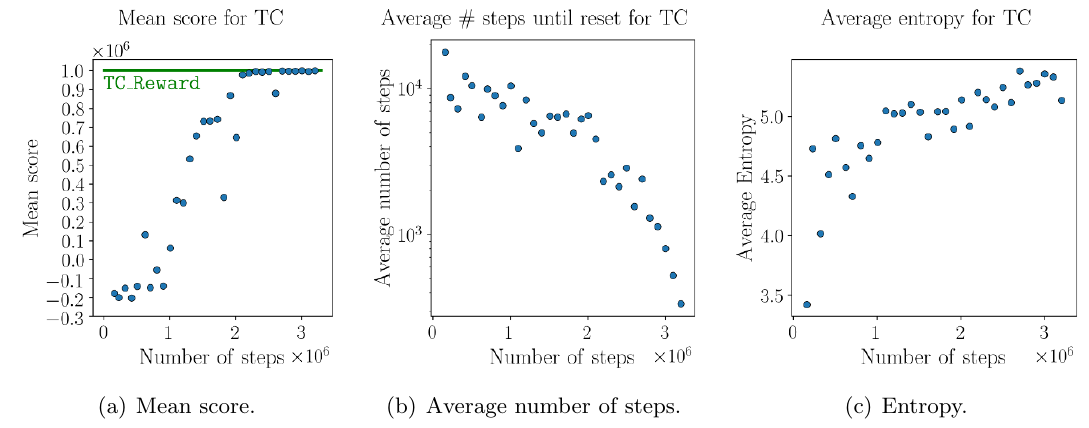
Figure 3 . Plots illustrating how the agent learns to solve the IIA tadpole